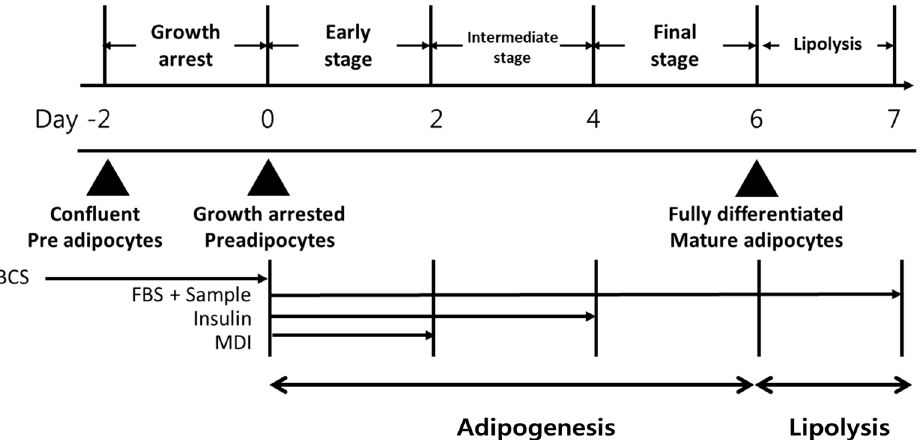
Figure 1. Scheme of 3T3-L1 differentiation. 3T3-L1 preadipocytes were differentiated into adipocytes without (control group) or with chrysoeriol. BCS, bovine calf serum; FBS, fetal bovine serum; MDI, 1 µ M dexamethasone + 0.5 mM 3-isobutyl-1-methylxanthine + 1 µ g/mL insulin.